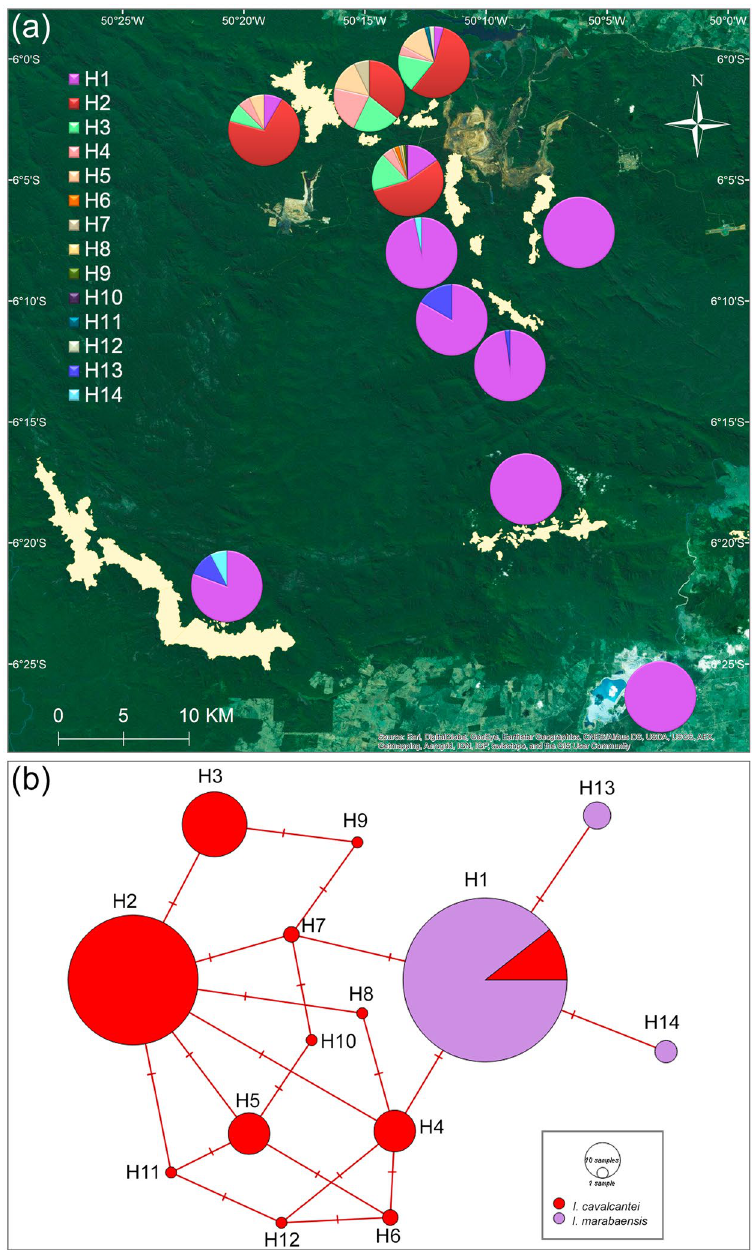
Figure 4. Nuclear genome ITS2 (a) allele distribution and (b) haplotypes